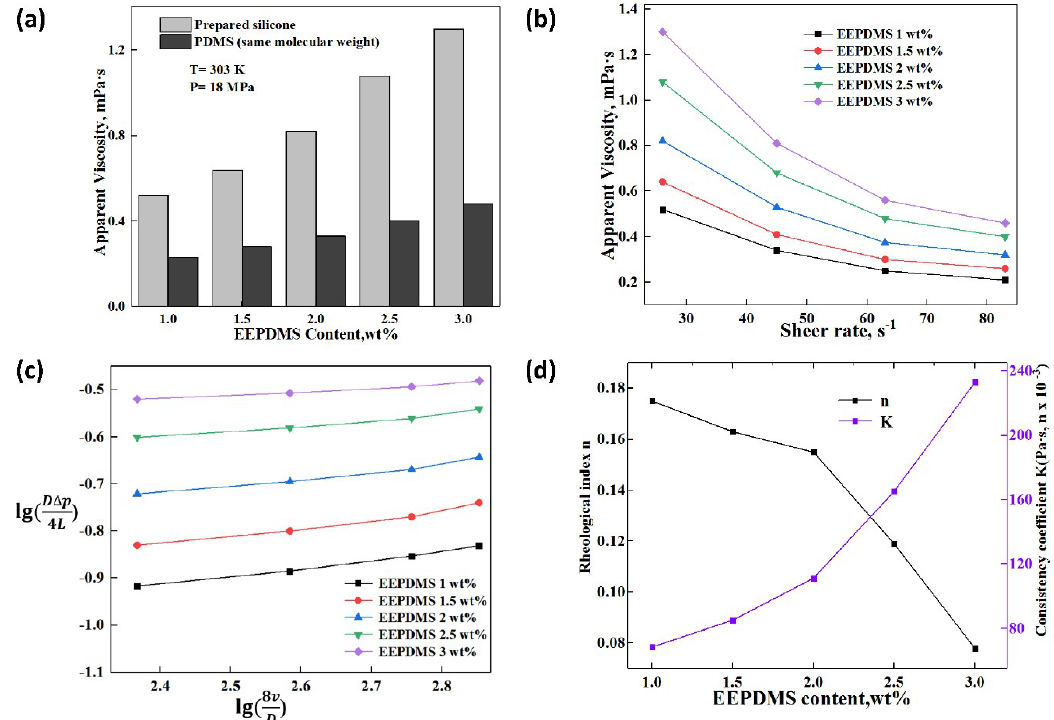
Figure 6. Effect of thickener content on the apparent viscosity and rheology. ( a )Temperature and apparent viscosity; ( b ) Shear rate and apparent viscosity; ( c ) Log τ w and Log(8 v / D ); ( d ) Rheological index, consistency coefficient and temperature.